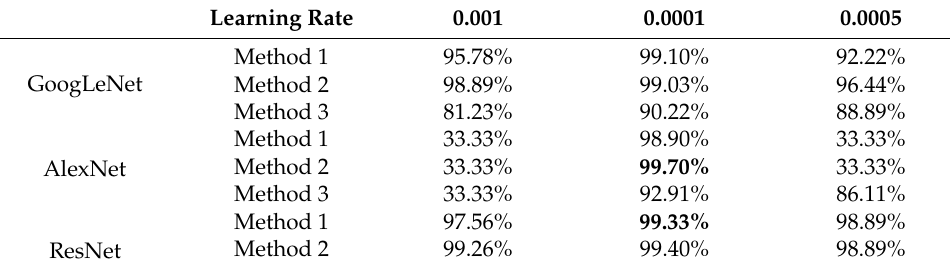
Table 6. Accuracy of the model at different learning rates.